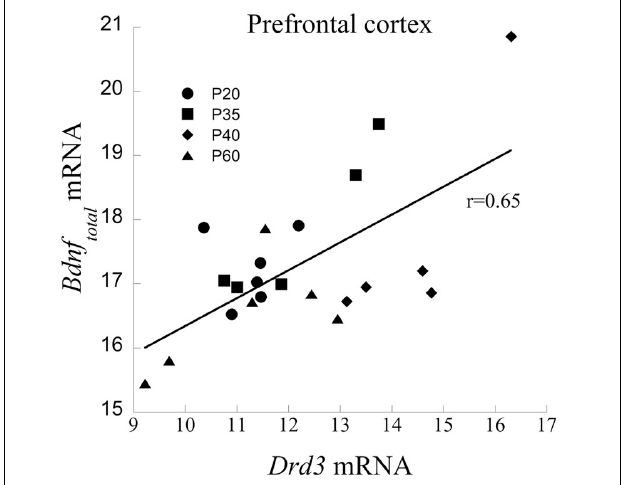
FIGURE 2 | Correlation between Drd3 and Bdnf mRNA from the PFC of developing rats at the ages of 20, 35, 40, and 60 days.